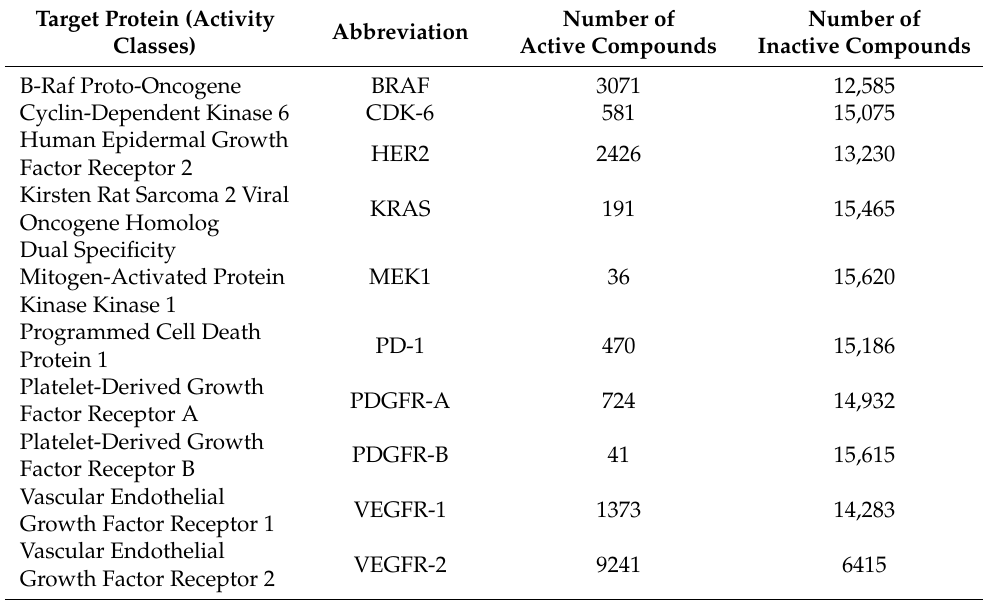
Table 7. The number of active and inactive compounds per activity class after data preprocessing and cleaning.